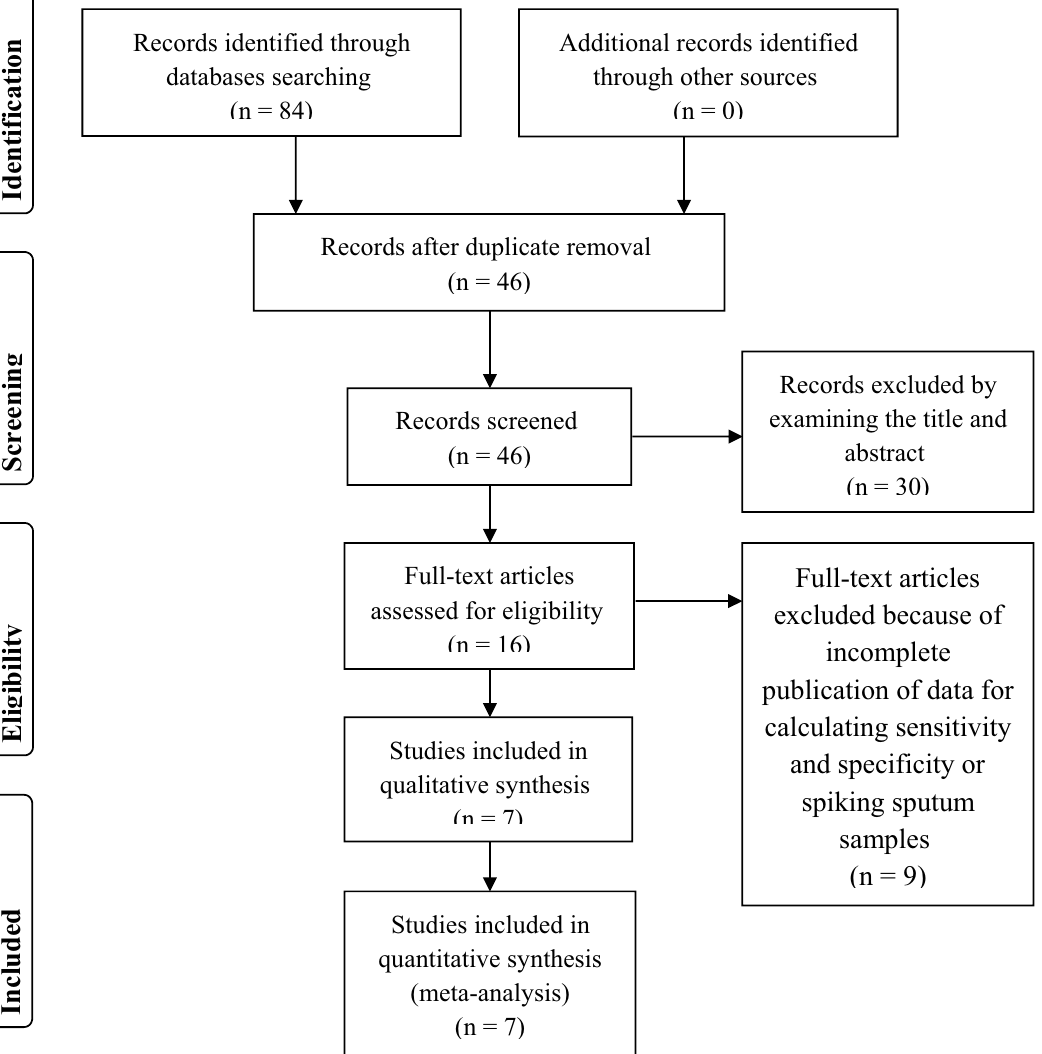
Figure 1. Study selection. PRISMA 2019 flow diagram. Database searches identified 84 records. Of the overall obtained studies, 38 were duplicates. From the 46 remaining studies, 30 were excluded either by examining the title or by examining the abstract. Of the remaining 16 studies, full-text examination resulted in identifying seven publications that are eligible for meta-analysis inclusion